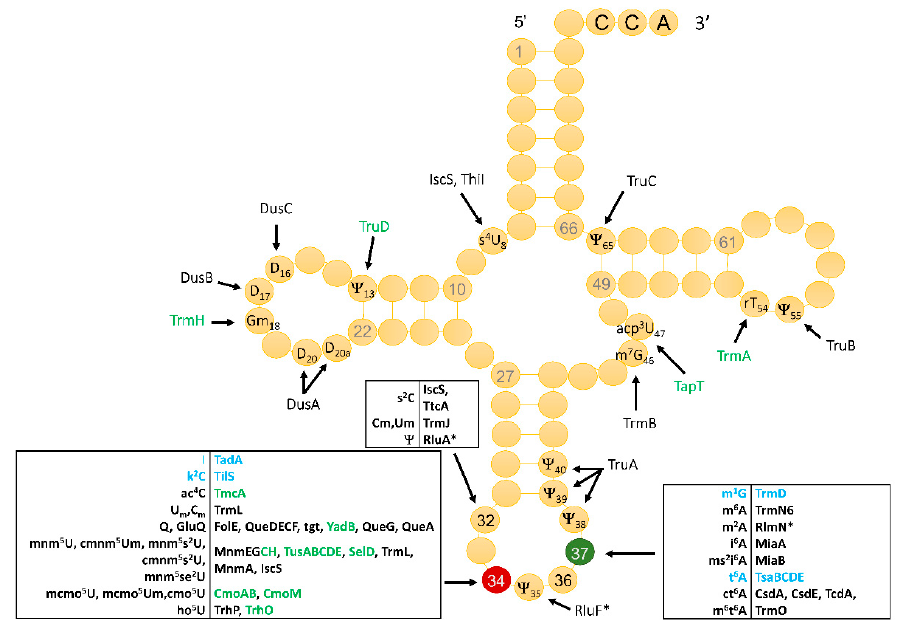
Figure 1. Escherichia coli tRNA modifications and corresponding enzymes. Proteins encoded by essential genes are in blue. Proteins with a * also modify rRNAs. The annotations were captured from the Björk and Hargevall review [11], from Uniprot, and the recent literature. In green are proteins with no ortholog in B. subtilis . Uniprot IDs for all proteins listed are given Table S1. Recently, a combination of mass spectrometry (MS) and tRNA-Seq methods to detect tRNA modifications was performed on Vibrio cholerae [19] , and even though this bacteria is closely related to E. coli , novel modifications were identified. Full analysis of the modified nucleosides present in tRNAs has been performed for three Gram-positive organisms, Lactococcus lactis [20], Streptomyces griseus [21], and Mycobacterium bovis BCG [22], but the links with the corresponding genes were not made in these studies. Bacillus subtilis sp subtilis strain 168 is the model Gram-positive that was sequenced in 1997 [23] , and an active community is keeping the genome annotation up to date [24,25]. Even the current knowledge of tRNA modification genes has not been well captured in SubtiWiki, as not all tRNAs have been sequenced. There are some clear gaps in knowledge, which we attempted to fill in the current study by analyzing the modifications found in B. subtilis tRNAs, using a combination of MS and tRNA-Seq methods, linking them to the corresponding validated or predicted gene, and experimentally testing a paralog case for the synthesis of the pseudouridines at positions 31 and 32. 2. Materials and Methods 2.1. Bioinformatic Analyses The B. subtilis genome that was used was NC_000964. The presence and numbers of isoforms were